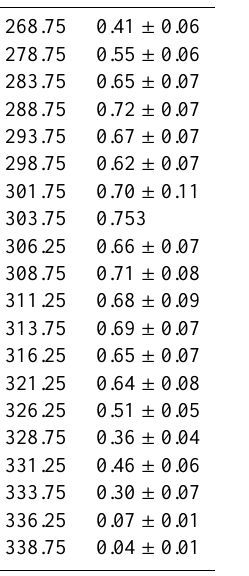
Table 6. As an example for a quantum yield data file, the contents of CH2O{H+HCO}_Smith(2002)_298K_268.75-338.75nm.txt is shown here. It belongs to the data set from Smith et al. (2002) shown in Table 5.